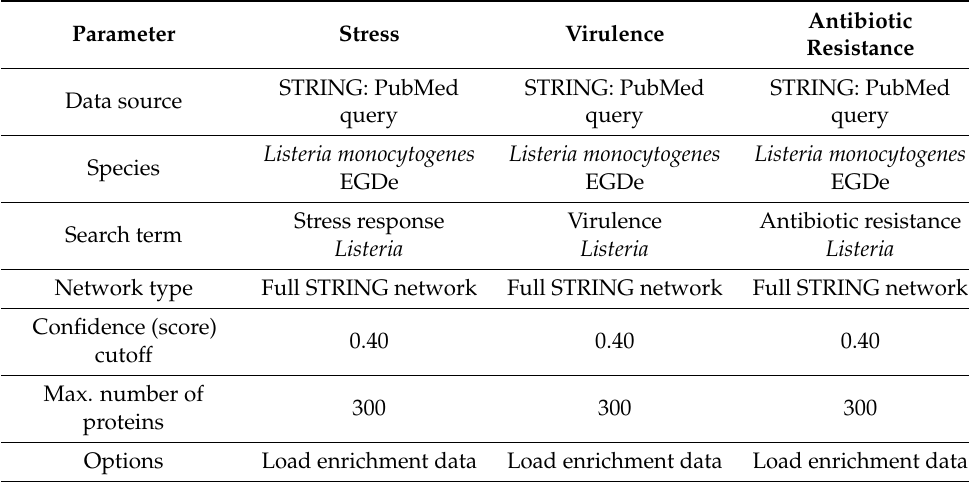
Table 1. STRING settings to generate protein list and create network. Antibiotic Parameter Stress Virulence STRING: PubMed STRING: PubMed Data source query query query Listeria monocytogenes Listeria monocytogenes Listeria monocytogenes Species EGDe EGDe